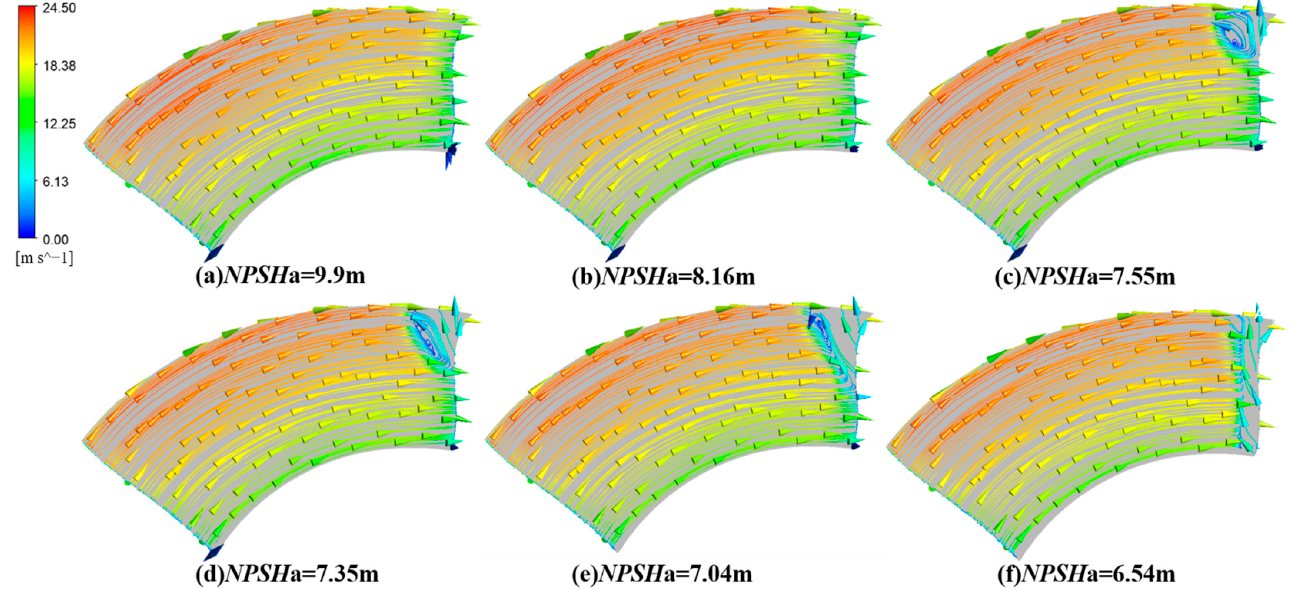
Figure 11. The streamline distribution of the impeller suction surface under different cavitation con- ditions.